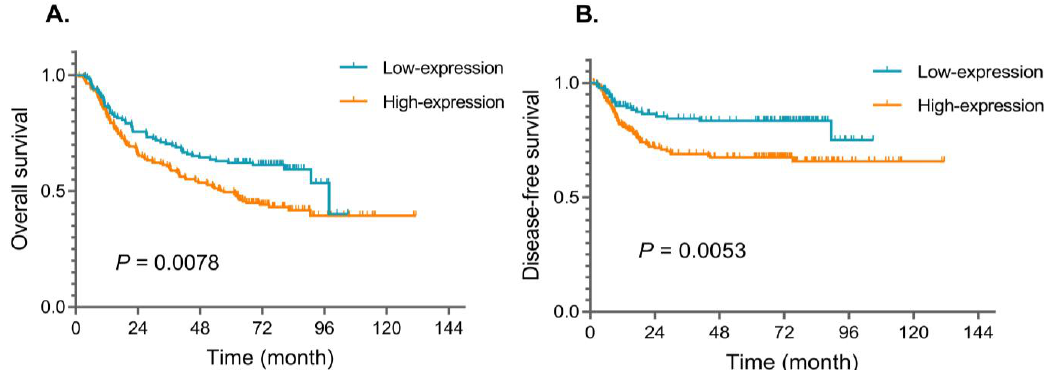
Figure 4. Overall survival ( A ) and disease-specific survival ( B ) curves for cohort of patients with stage I-IV HNSCC according to the expression level of FOXD1. Table 2. Univariate and multivariate analysis on overall survival and disease-free survival by Cox regression model.